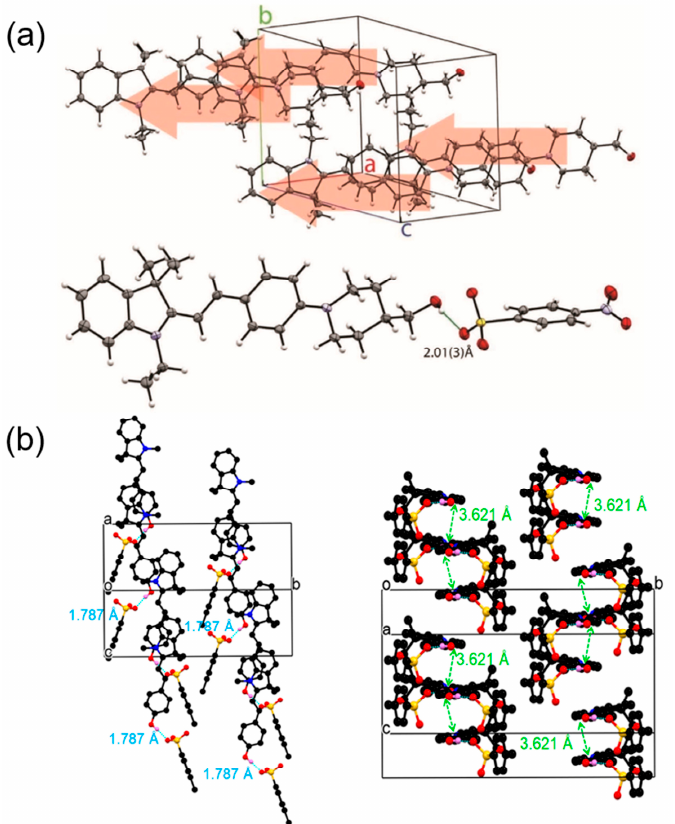
Figure 13. ( a ) Crystal stacking of EHPSI-4NBS [52], and ( b ) molecular stacking along the [101] direction in OHI-T [53].